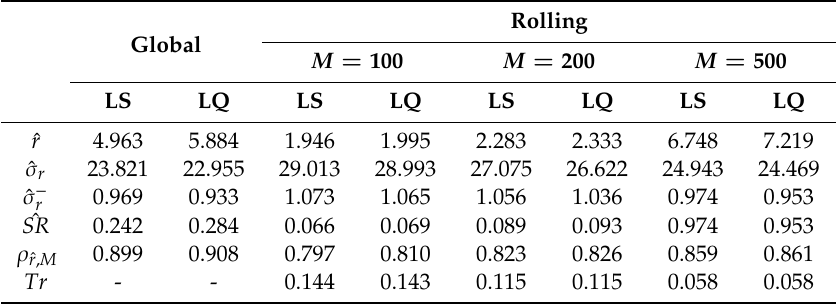
Table 1. Average statistics for the 1000 simulated